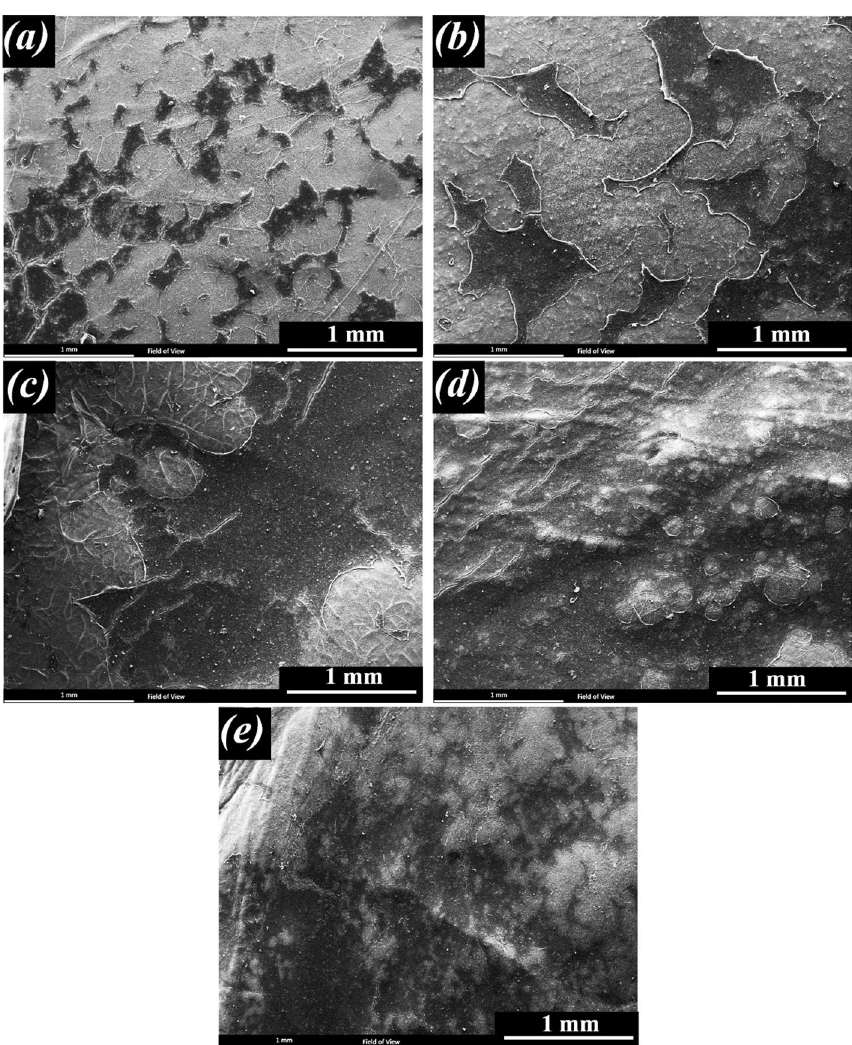
Figure 15. Morphology of the ARPE cells on the scaffolds after 7 day of culture (scale bar, 1 mm), ( a ) PCL ( b ) PCL-10HAMP ( c ) PCL-20HAMP, ( d ) PCL-30HAMP and ( e )